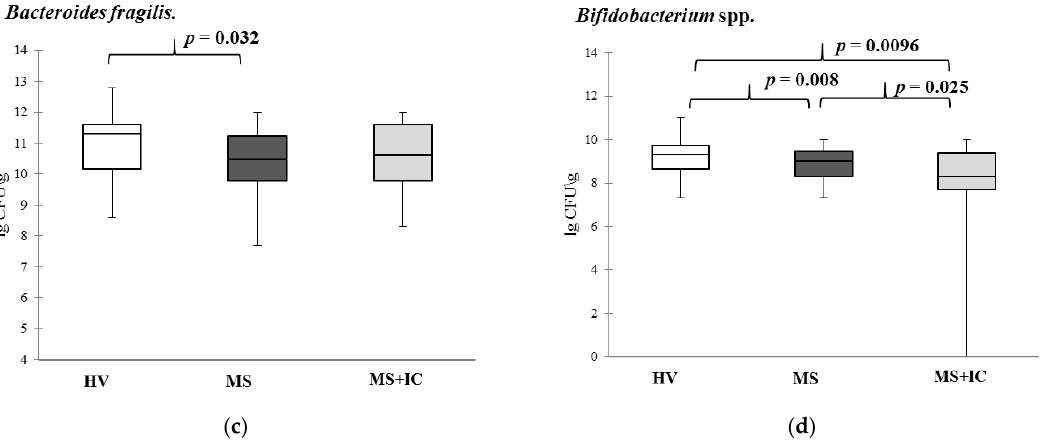
Figure 7. Microbiota content of patients with MS before and after IC by qPCR. Escherichia coli ( a ), Enterobacter spp. ( b ), Bacteroides fragilis ( c ) and Bifidobacterium spp. ( d ). Notes: HV — healthy volunteers; MS — patients with metabolic syndrome; MS+IC — patients with metabolic syndrome after consumption of indigenous consortium. Results are presented as median (25%; 75%). Metagenome 16S rRNA Study